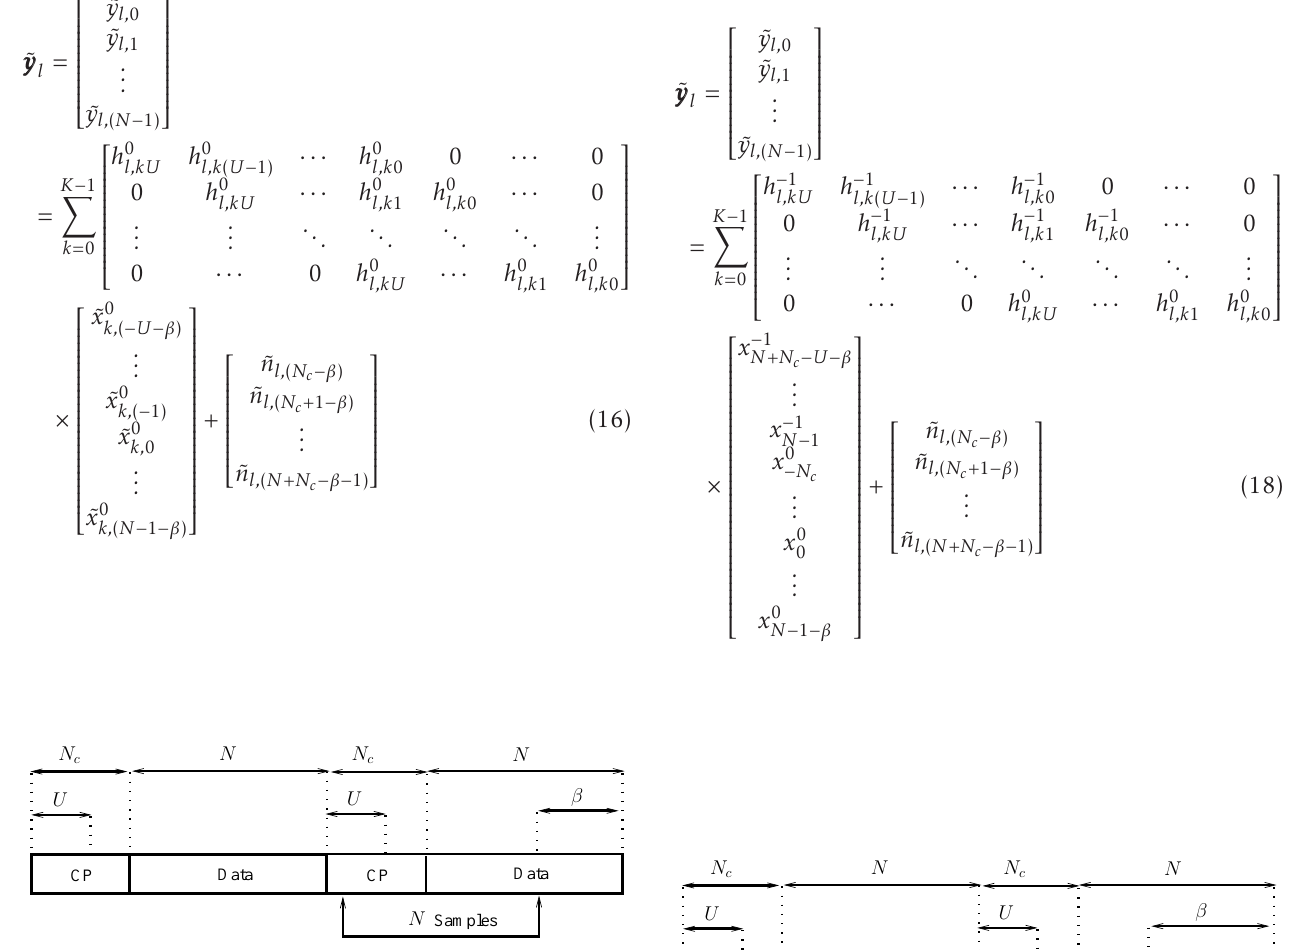
Figure 5. Illustration for the scenario of quai-synchronous sensing with small ISI, where N